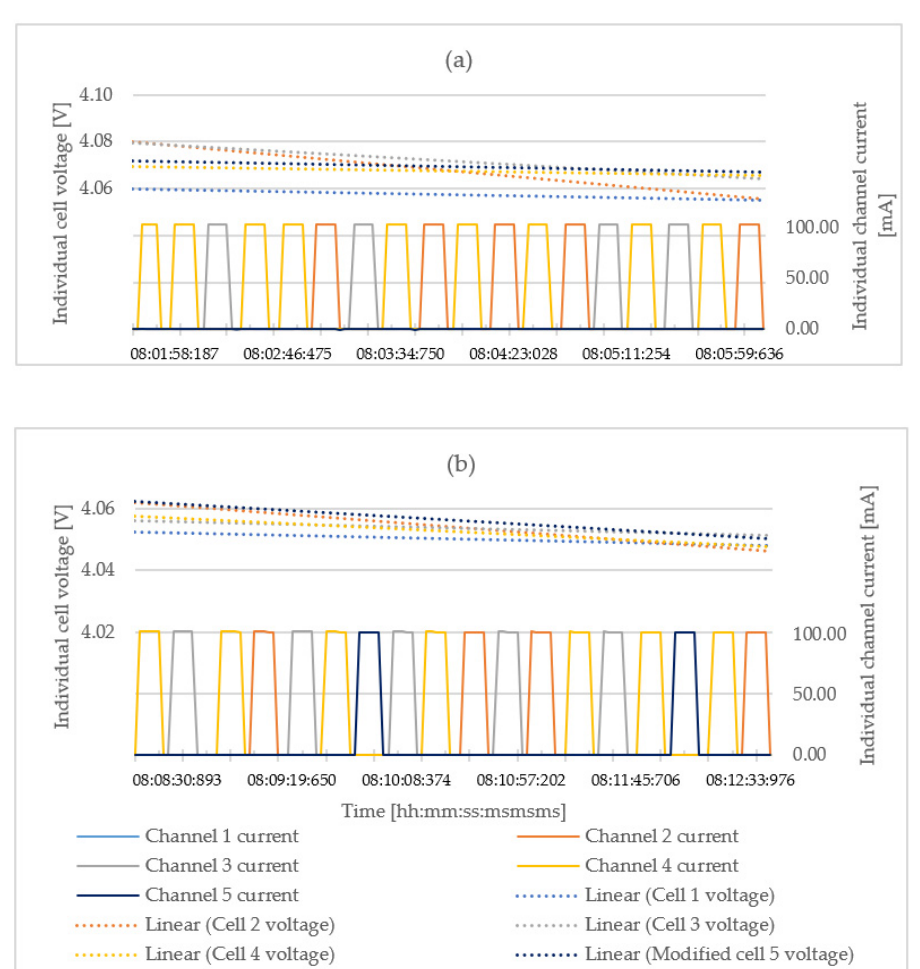
Figure 14. Initial ( a ) and final ( b ) battery-cell voltage (trendlines) and balancing channels current oscillograms in the balance system configuration.